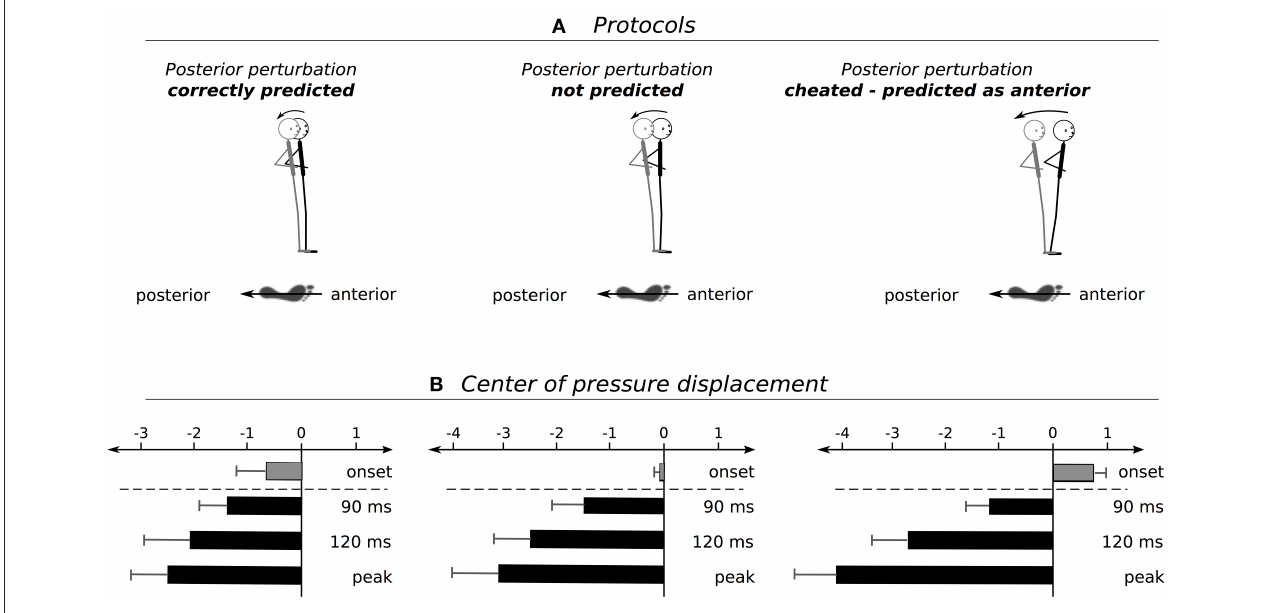
FIGURE 2 | (A) Schemes show the postural set at perturbation onset with respect to predicted (left), unpredicted (middle), and cheated (right) perturbations and (B) the subsequent changes in body positioning to compensate for the deterioration of posture. Graphs illustrate changes of the center of pressure (COP) displacement at onset prior to the surface translation (gray bars), 90ms, 120ms and at the peak displacement after perturbation onset (black bars).